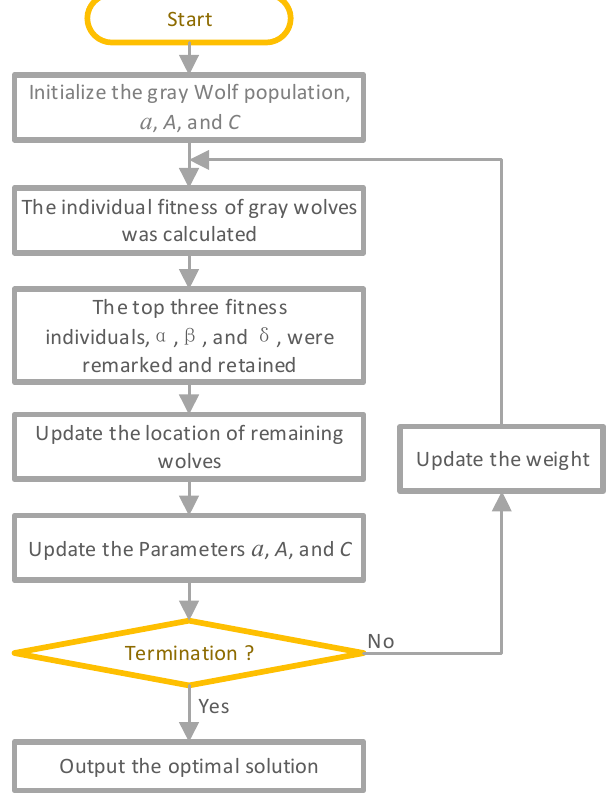
Figure 2. The process of GWO.